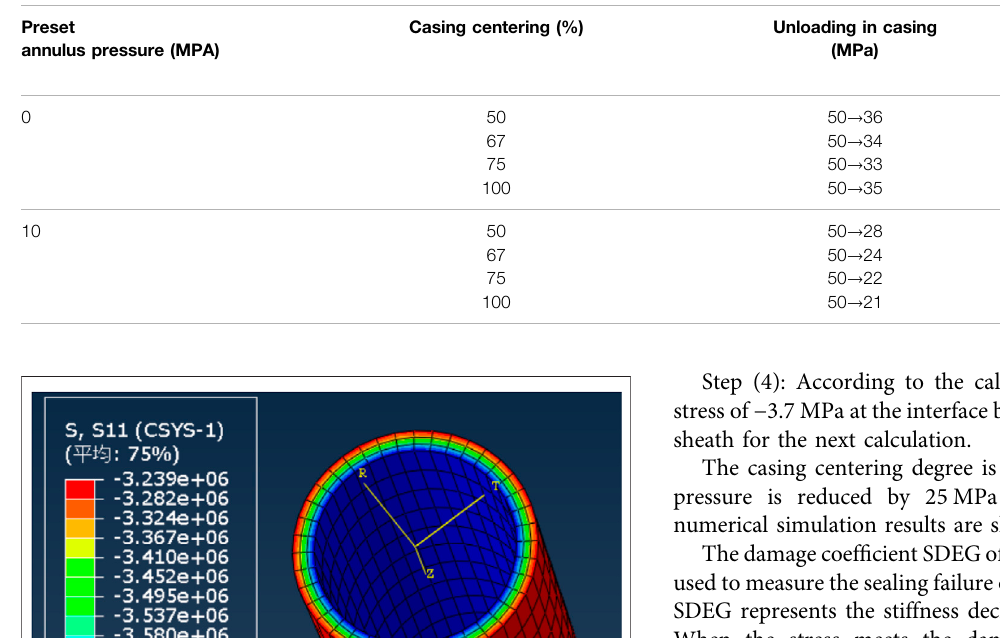
TABLE 6 | Effect of the pressure relief in casing on the sealing integrity under casing eccentricity.